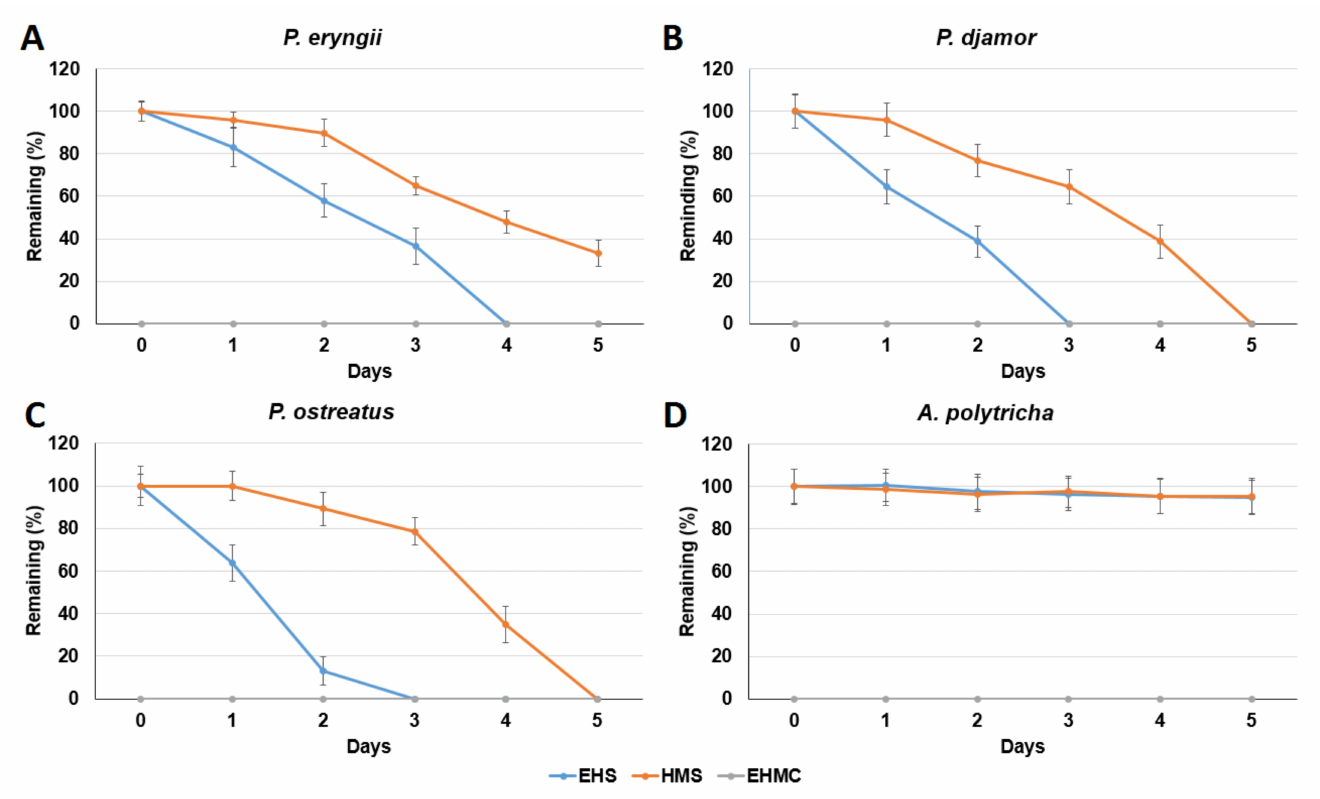
Figure 3. Removal of three UV filters (2 ppm) by enzyme extracts of the spent mushroom compost of four mushrooms (( A ) P. eryngii , ( B ) P. djamor , ( C ) P. ostreatus and ( D ) A. polytricha ). Data from triplicate experiments are presented as the mean ± SE. EHMC: ethylhexyl methoxycinnamate, EHS: 2-ethylhexyl salicylate, HMS: